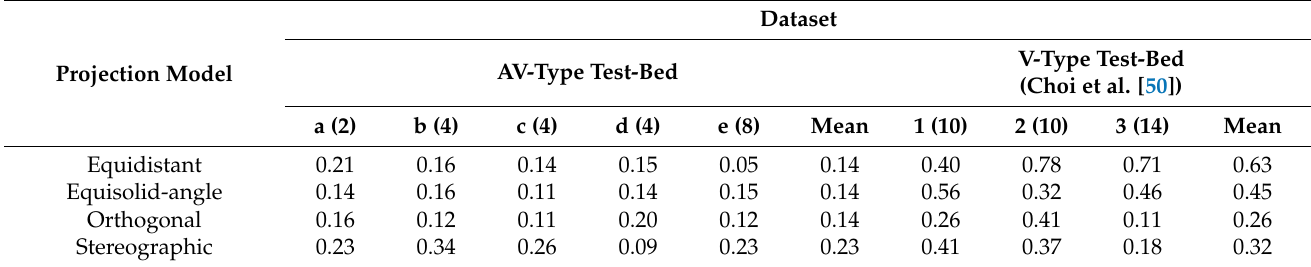
Table 15. Comparison of absolute error of principal point coordinates (pixel).